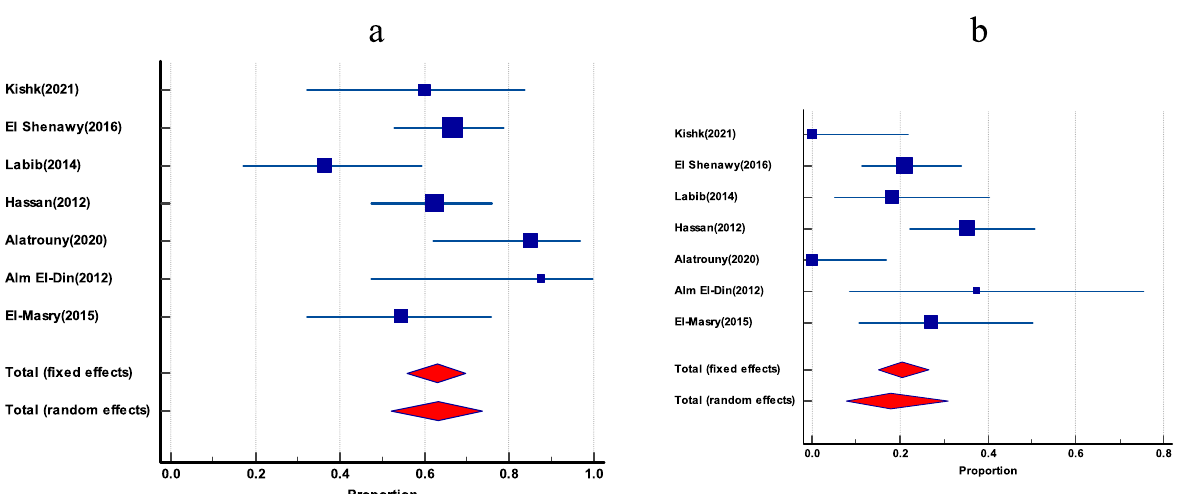
Fig. 7 The dissemination of VanA and VanB among VRE. a Forest plot of VanA among VRE. b Forest plot of VanB gene among VRE